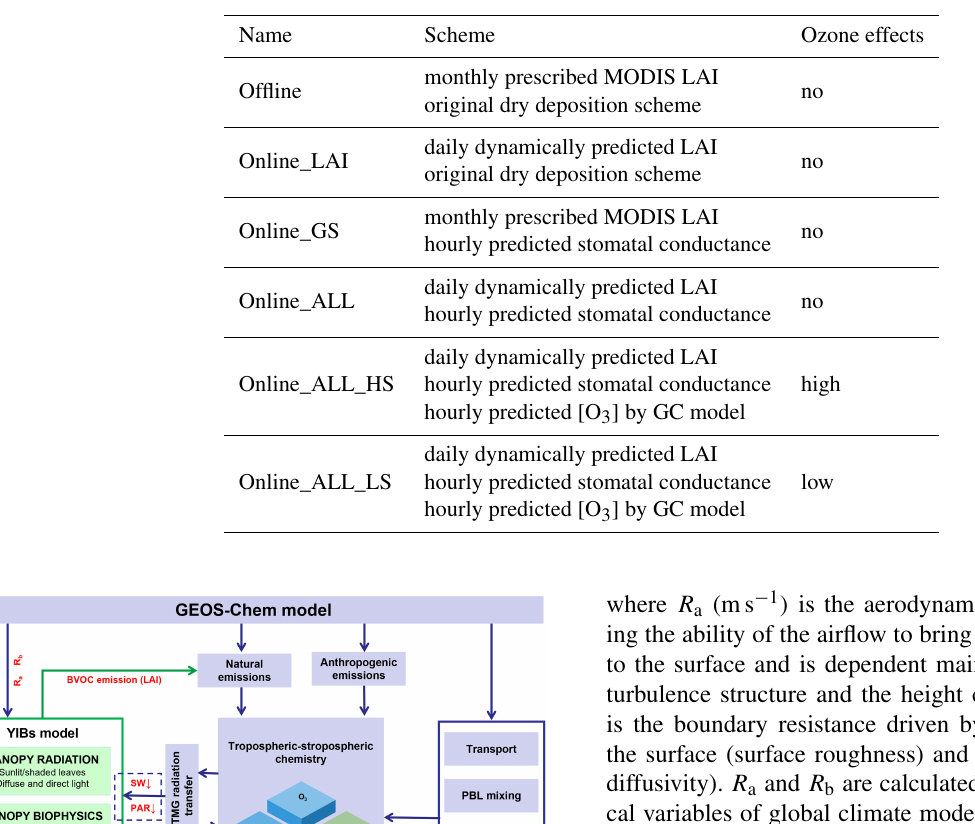
Table 1. Summary of simulations using the GC-YIBs model.